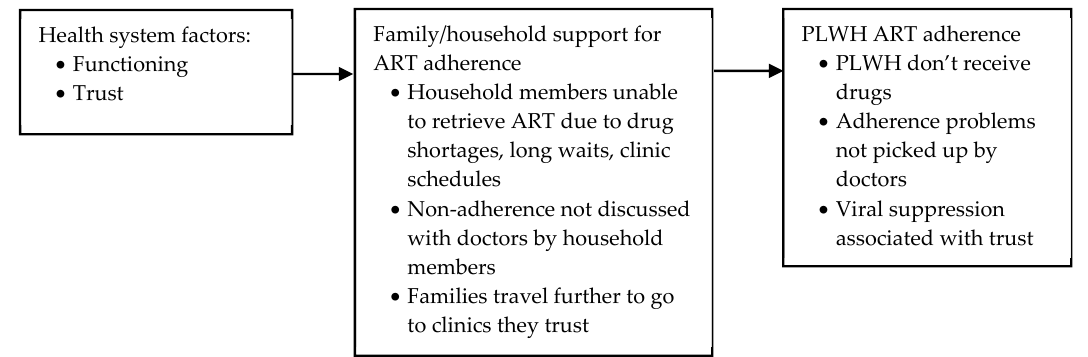
Figure 9. Impact of health system factors on household support and, consequently, ART adherence.